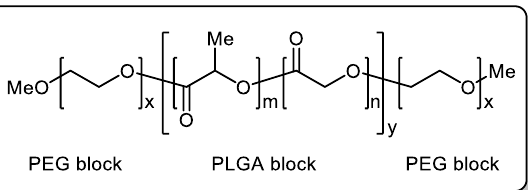
Figure 3. The chemical structure of PEG – PLGA – PEG triblock copolymer. For PEG 13 – PLGA 10 – PEG 13 , x = 13, y = 10, m = 3, n = 1. x = 13, y = 10, m = 3, n =